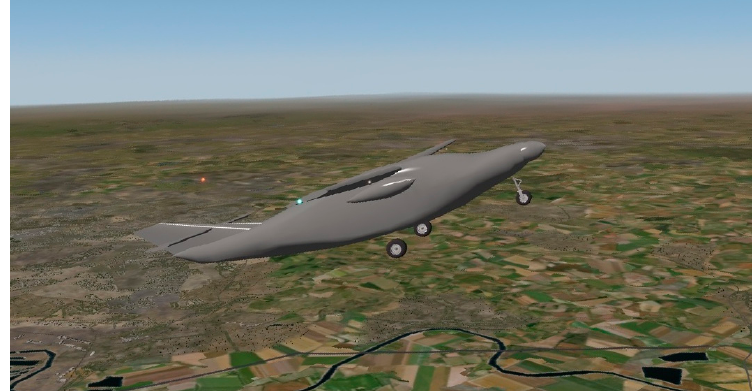
Figure 14. X-Plane “Plane-Maker” AUXX hybrid model.